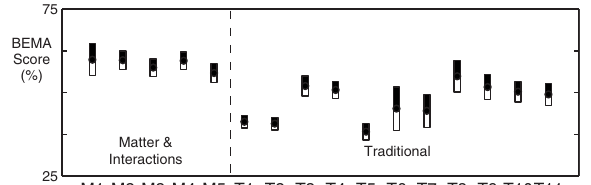
FIG. 4. Pretest BEMA score distributions for Georgia Tech and Purdue—the distributions of BEMA test scores for students before completing an E&M course with either a traditional (cid:1) dotted-dashed line (cid:2) or M&I curriculum (cid:1) solid line (cid:2) are shown for data from (cid:1) a (cid:2) GT (cid:1) N =1319 for traditional students; N =321 for M&I students (cid:2) and (cid:1) b (cid:2) Purdue (cid:1) N =78 for traditional students; N =76 for M&I students (cid:2) . The plots are constructed from binned data with bin widths equal to approximately 6.7% of the maximum possible BEMA score (cid:1) 100% (cid:2) .